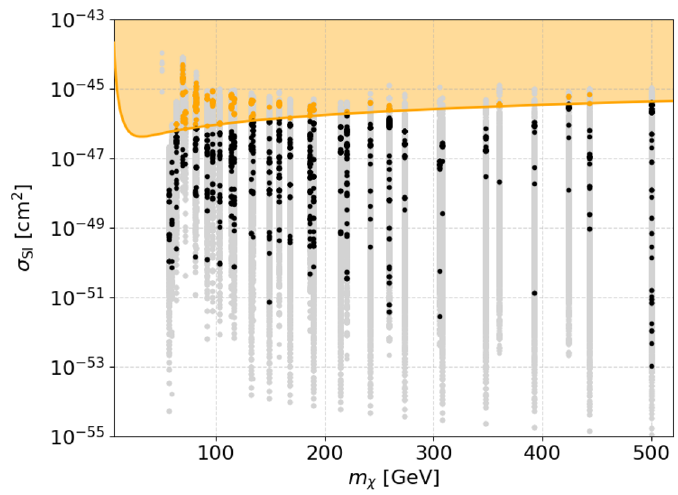
Figure 6 . The direct-detection cross section vs. DM mass where the orange shaded region is excluded by the XENON1T experiment. The black and orange points produce a (cid:12)rst-order phase transition while the gray points fail to do so. The black points are allowed by the XENON1T bound while the orange points are